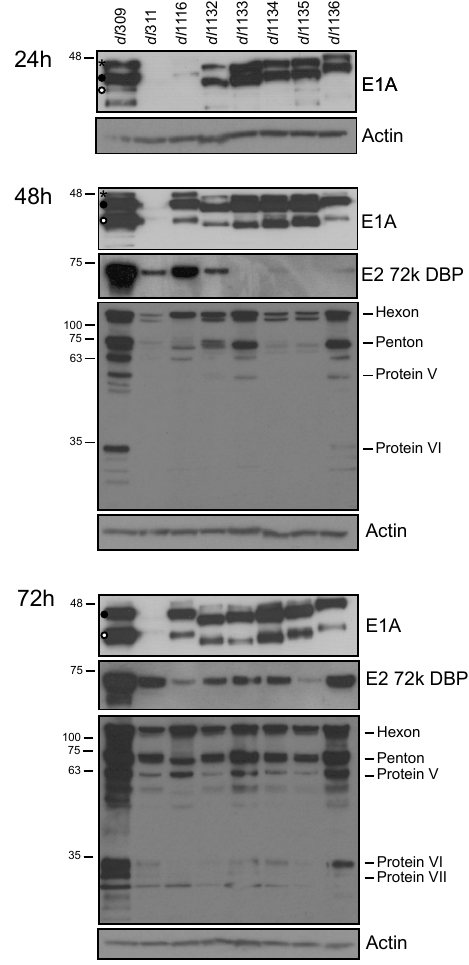
Figure 3. Viral protein levels in infected WI-38 cells. Arrested WI-38 cells were infected at a MOI of 100 and proteins were extracted at the indicated time points. Total cell lysate (20 μ g) was resolved by SDS polyacrylamide gel electrophoresis, blotted for the indicated proteins and visualized using film. Actin was used as a loading control. * denotes E1A289R, • denotes E1A243R and ° denotes E1A171R.